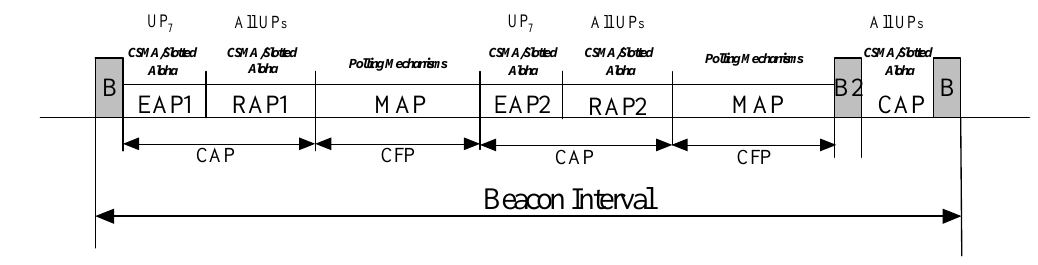
Figure 5. Configuration of access phases with beacon intervals.